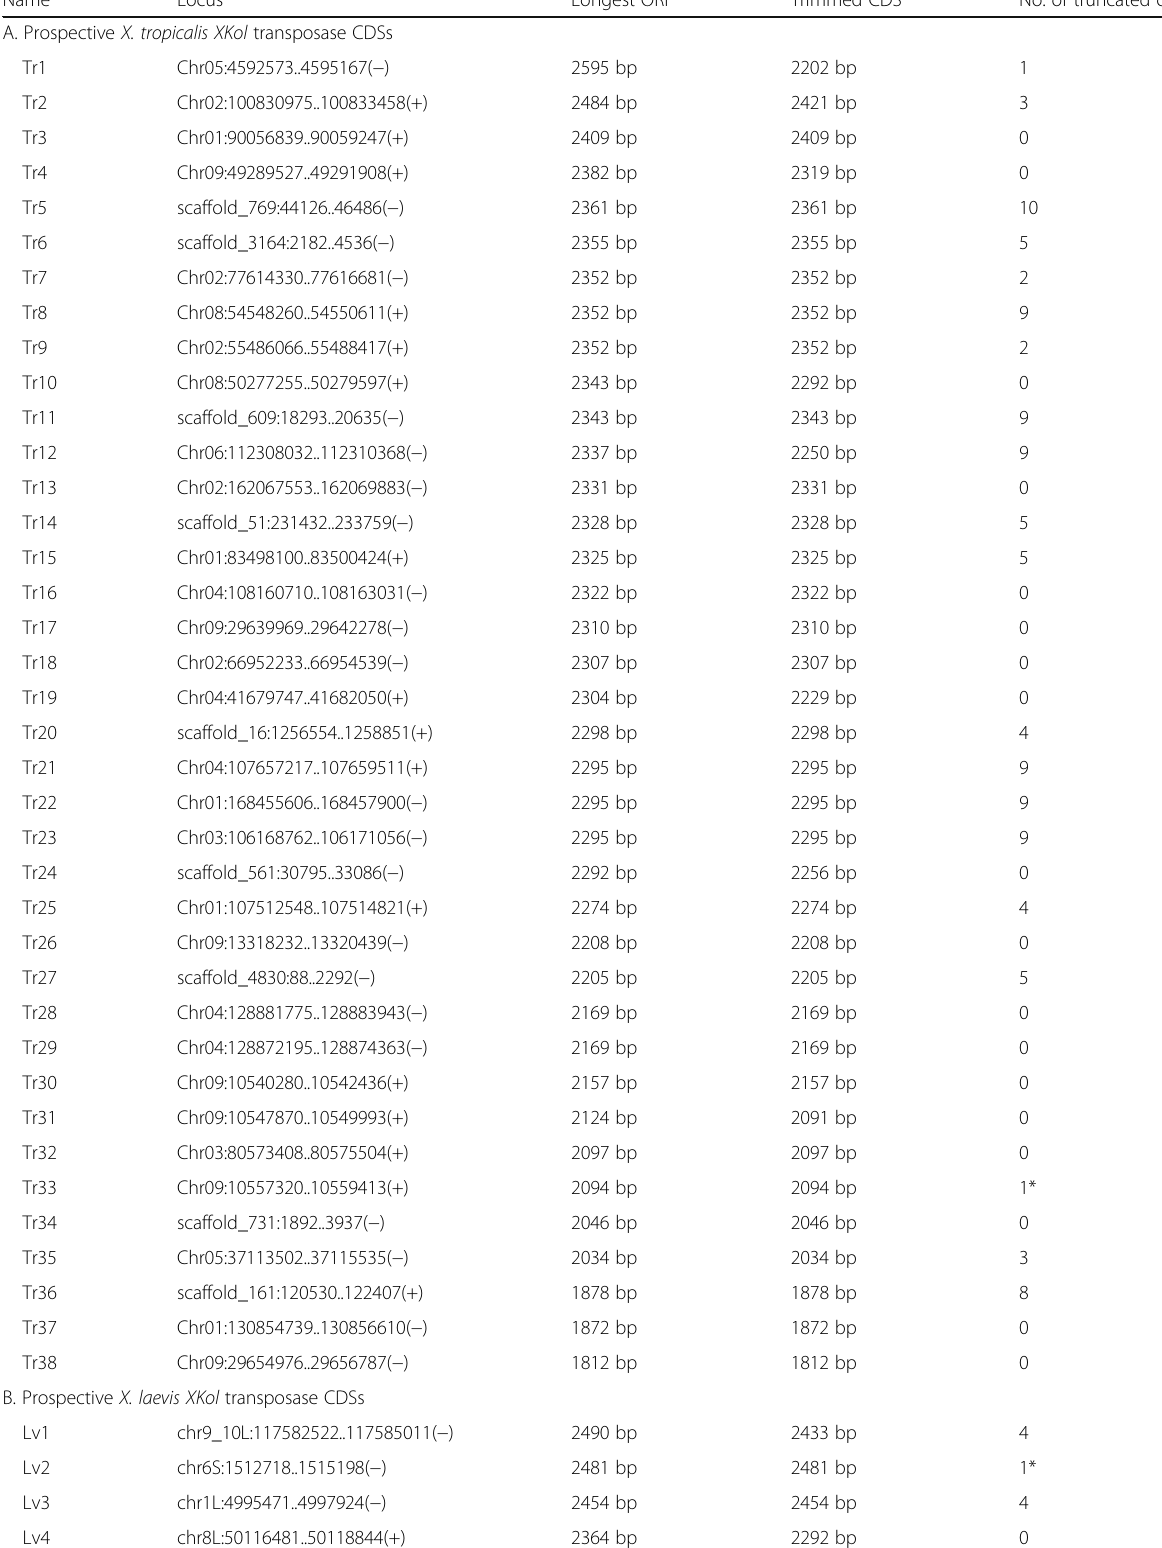
Table 1 Prospective Xenopus XKol transposase